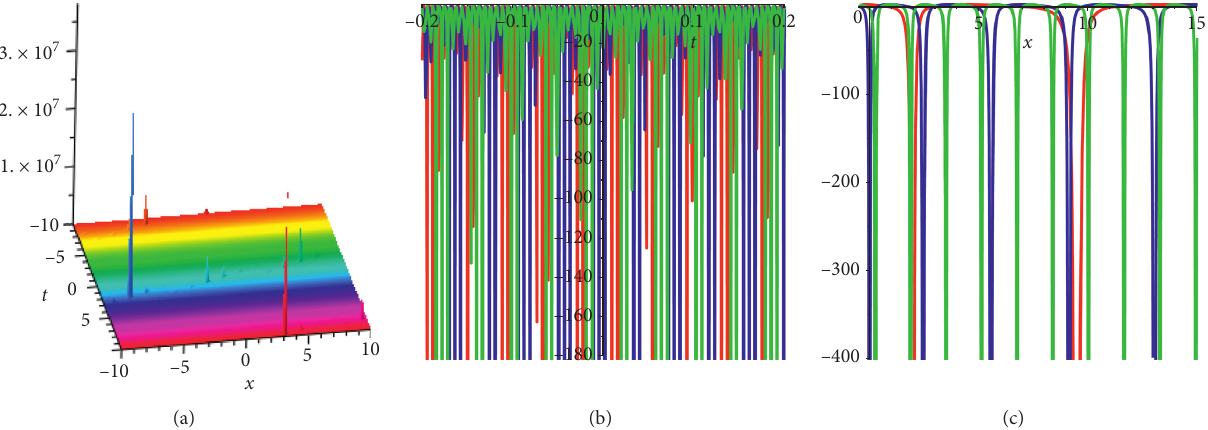
( x, y, t ) at A � 1 , B � 2 , a � 3 ,b � 2 , k � 1 . 5 , ω � 2 , β � 3 , c � − 1 ,y � 2 , and α � 1 for (a) 3D plot and (b) and 2 0 0